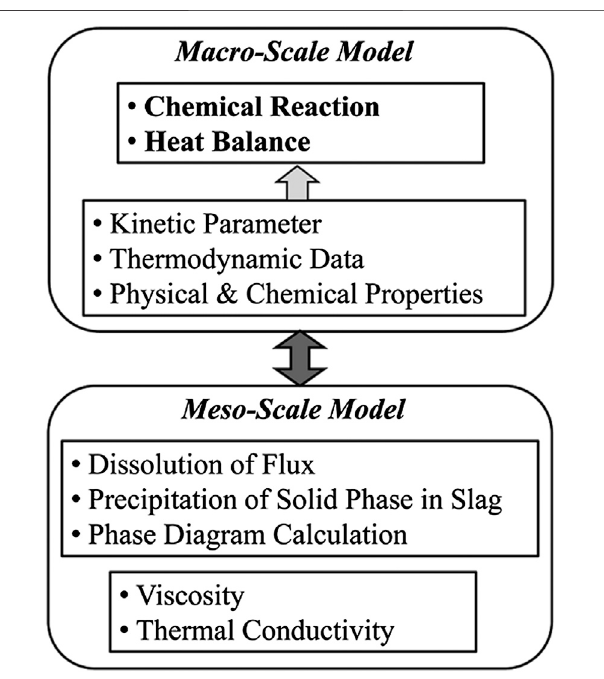
FIGURE 6 | Basic structure of the Multi-Phase Slag Re fi ning (MPSR) model (Kitamura et al., 2014). [Figure 1 of (Kitamura et al., 2014), Copyright The Iron and Steel Institute of